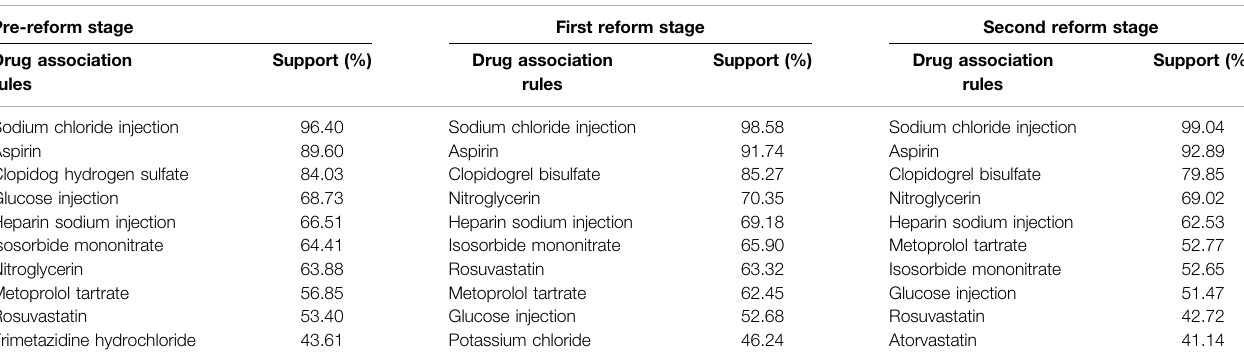
TABLE 1 | The support of DHI combined with one drug based on association